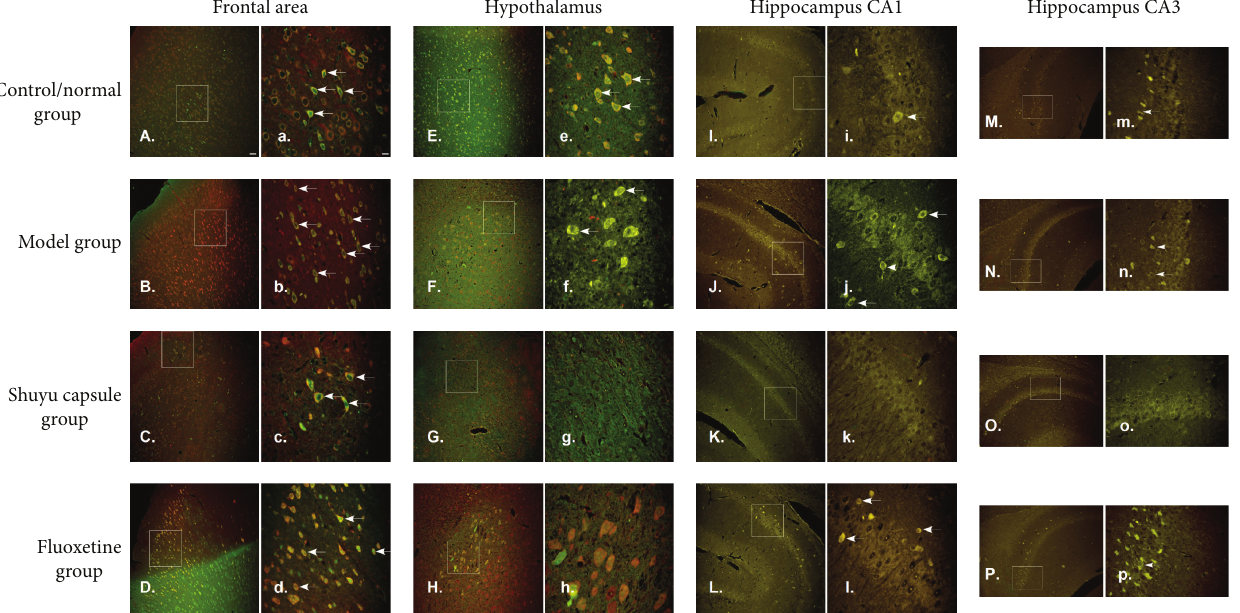
Figure 3: 5-HT R- and 5-HT R-positive cell staining. 5-HT R- and 5-HT R-positive cells from different cerebral areas were stained, 3A 3B 3A 3B including the frontal lobe (A–D, a–d), hypothalamus (E–H, e–h), hippocampus CA1 (I–L, i–l), and hippocampus CA3 (M–P, m–p). The R and 5-HT R antibodies: the control/normal group (A, E, I, M, a, e, I, and m), model following samples were stained with both 5-HT 3A 3B group (B, F, J, N, b, f, j, and n), Shuyu capsule group (C, G, K, O, c, g, k, and o), and positive-control fluoxetine group (D, H, L, P, d, h, l,